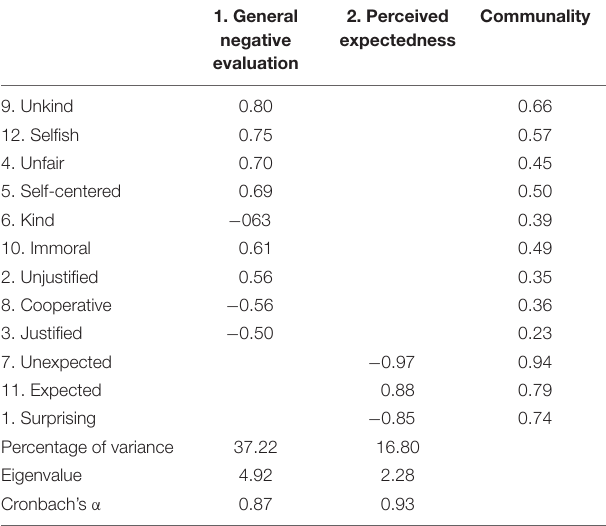
TABLE 1 | Factor loadings based on an exploratory factor analysis with a principal axis factoring and direct oblimin rotation on 12 evaluation items ( N = 124).